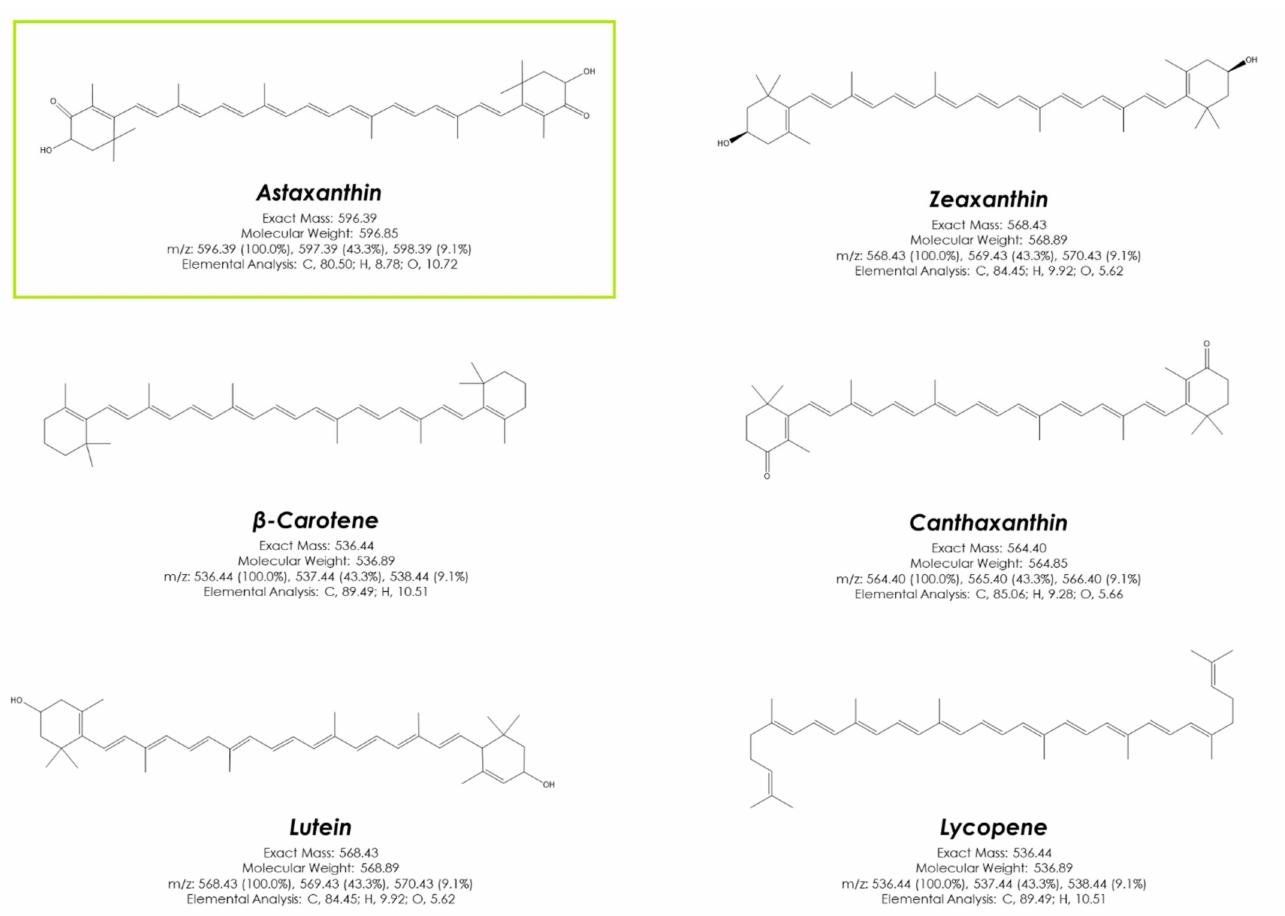
Figure 3. Chemical structure of industry-relevant carotenoids. Astaxanthin, the most potent natural antioxidant is highlighted in